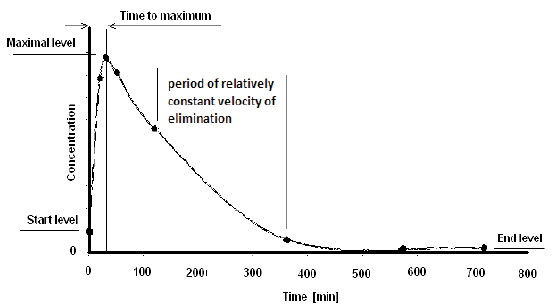
Figure 2. General view of a kinetic curve of an oral applied xenobiotic, and the main points and segments, used as “Kinetic variables”: Start level, End level, Maximal level, Time to maximum and relatively linear segment for elimination rate